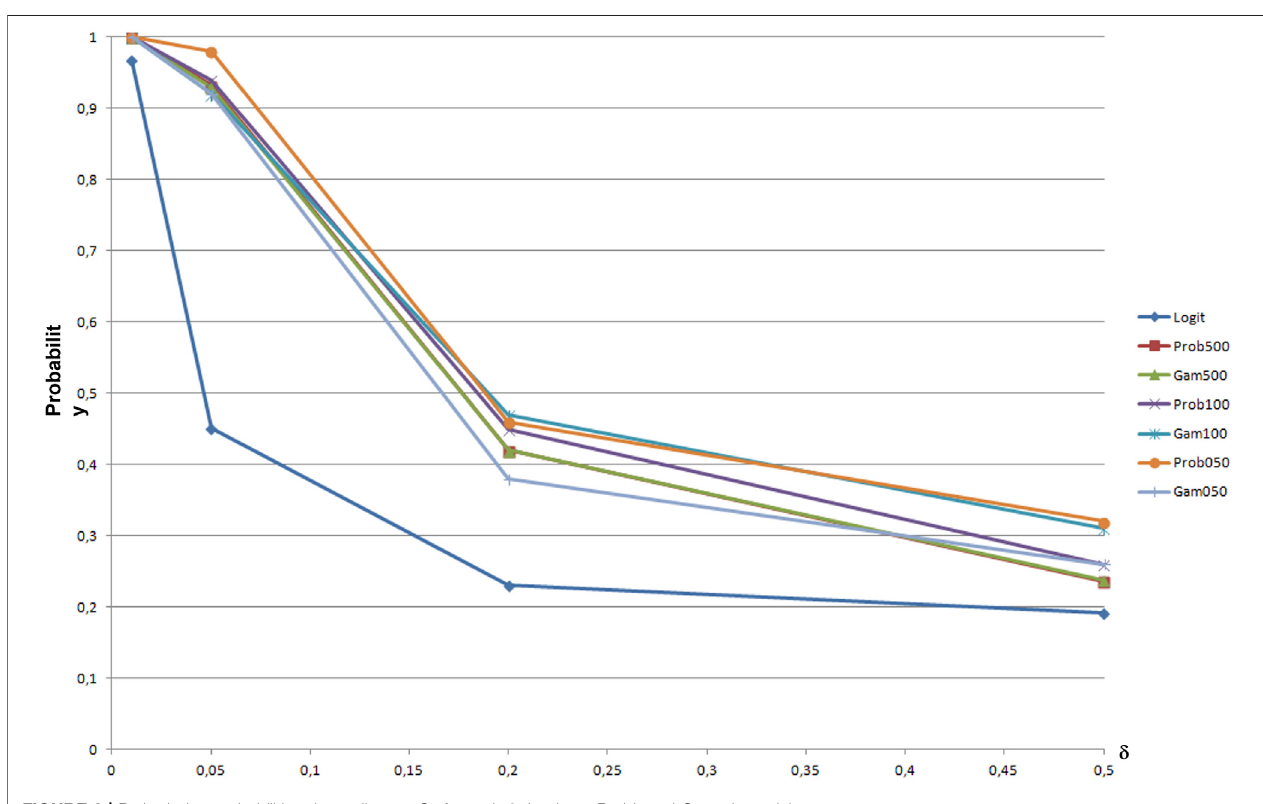
FIGURE 3 | Path choice probabilities depending on Cv for path 0: Logit vs. Probit and Gammit models.